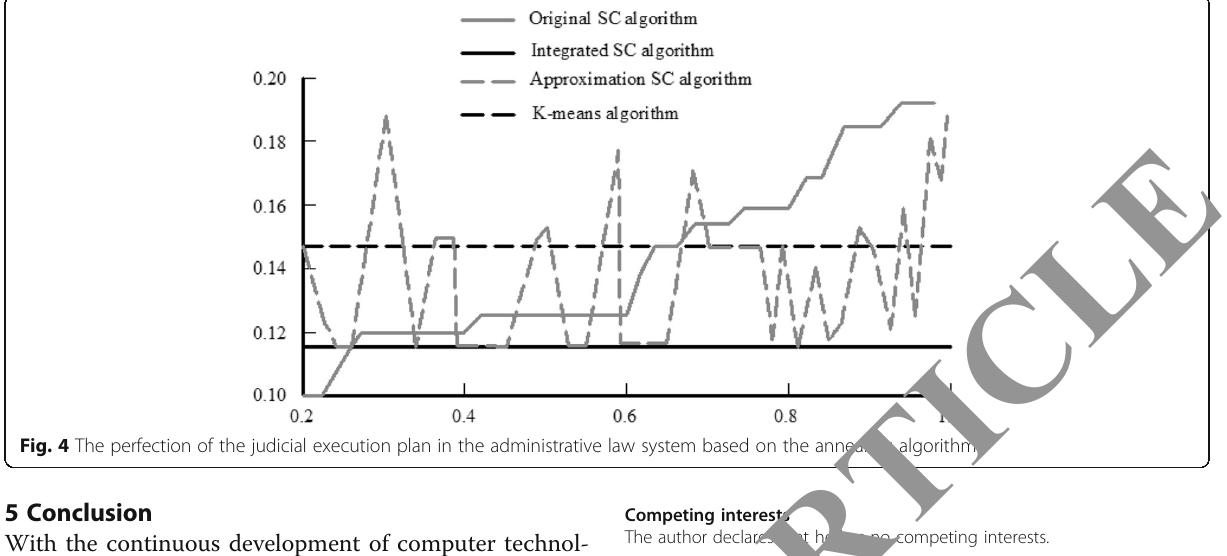
Fig. 4 The perfection of the judicial execution plan in the administrative law system based on the annealing